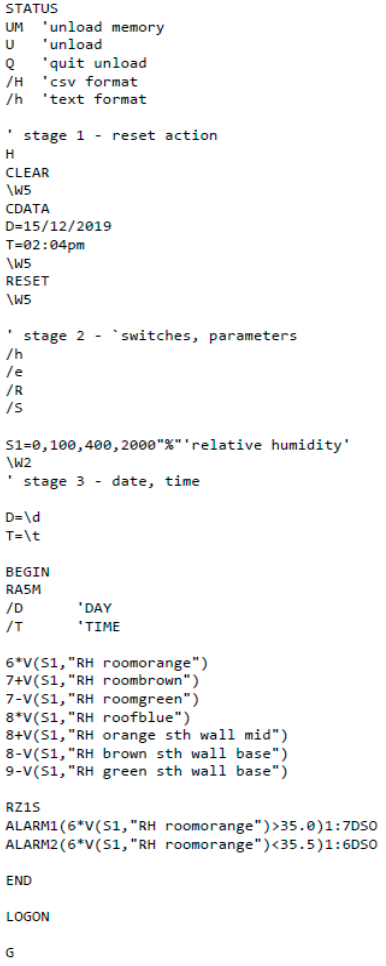
Figure 16. Example of relative humidity programming code. Table 1. Summary of sensors and other equipment.